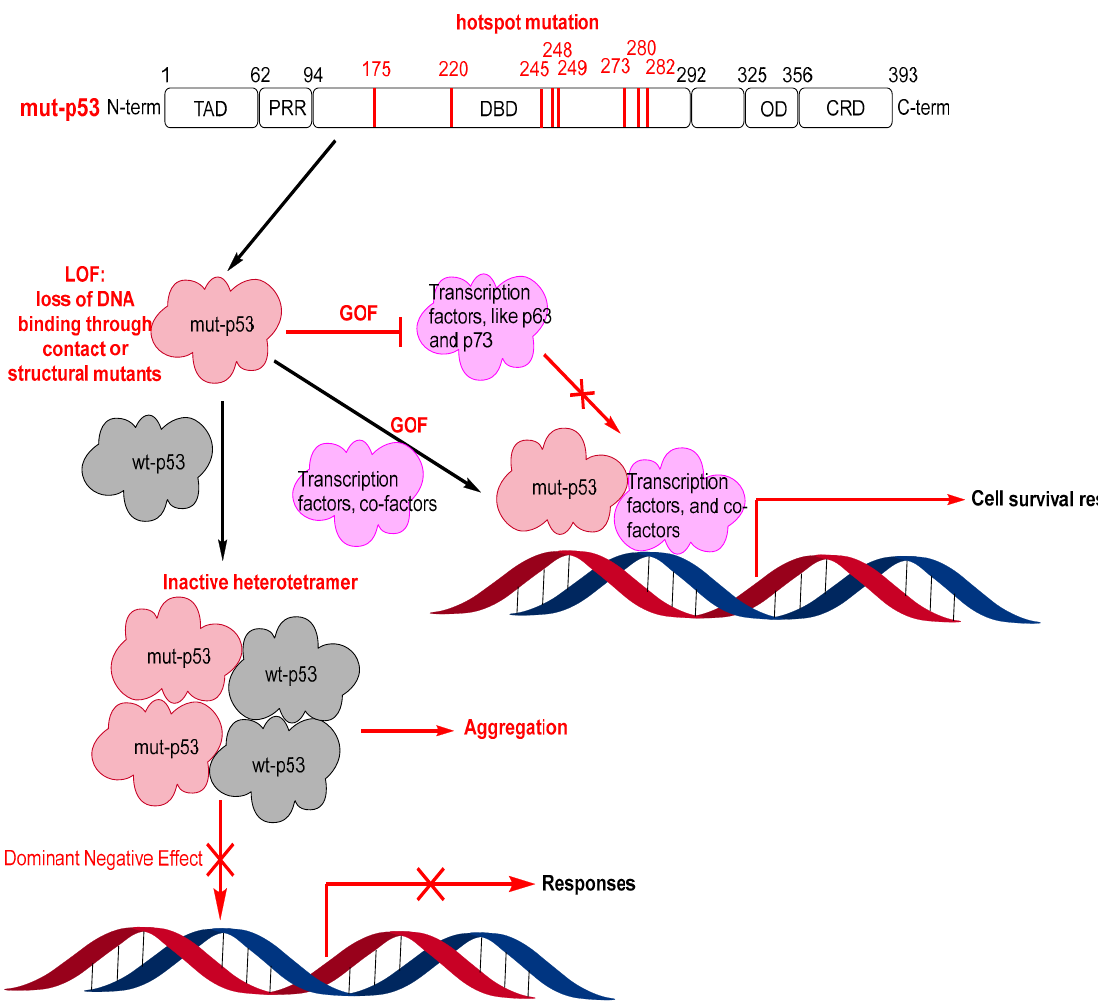
Figure 11. Mutant p53 hotspot mutations, loss of function (LOF), gain of function (GOF), and dominant negative effect (DNE).